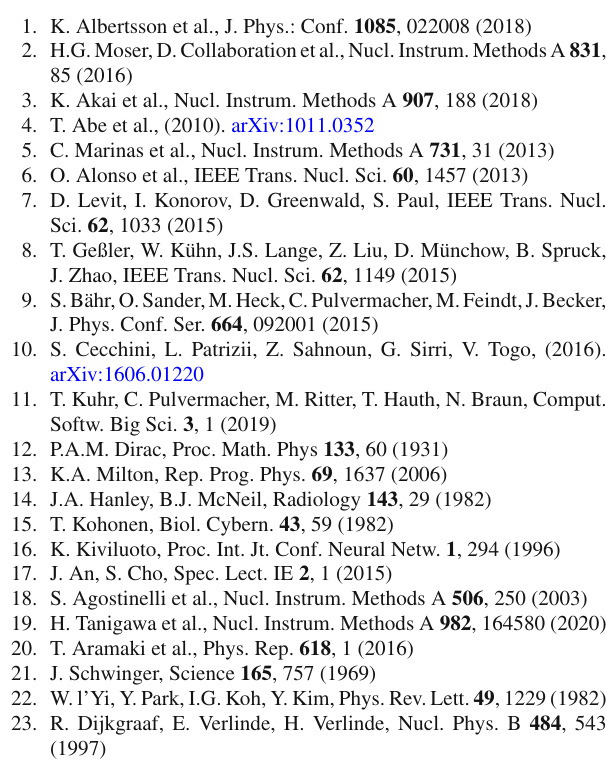
current PXD readout scheme, similar to other HIPs such as the hypothetical magnetic monopoles.